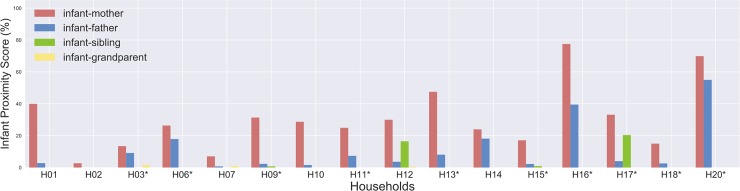
Infant proximity score (IPS) between each family members and the infant (IPS = percentage of time spent by each family member in proximity to the infant, over the total time spent by the infant at home).Pink = IPS between mother and infant; blue = IPS between father and infant, green = IPS between sibling and infant; yellow = IPS between grandparent and infant. Families in which the infant is exclusively breastfed are labelled with *.